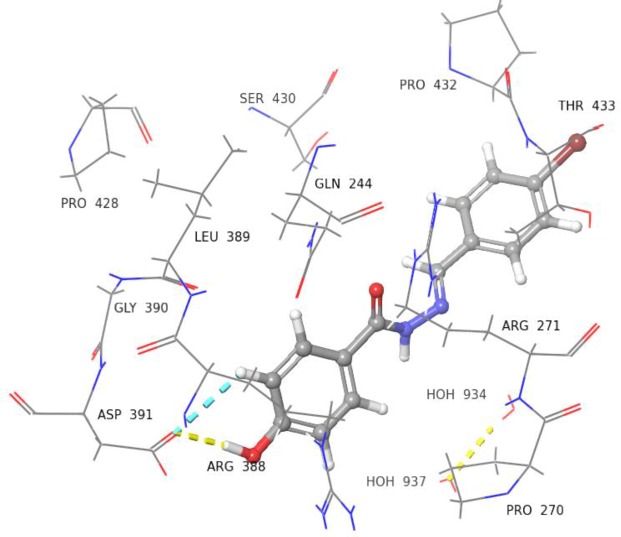
3D Representation of docked pose of compound 14 (IC50 = 158.0 ± 1.0 μM).It is showing interaction with Asp391 via H-bonds (yellow and blue dotted lines).